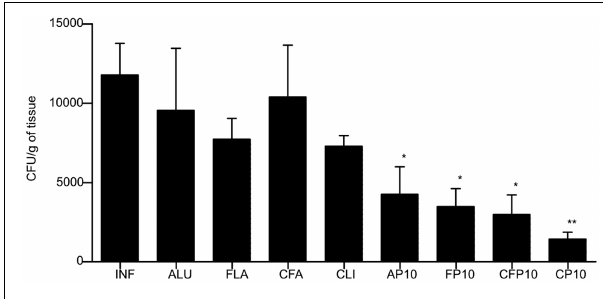
FIGURE 1 | Colony forming units (CFU) from lungs of BALB/c mice infected intratracheally with 3 × 10 5 yeast cells of Pb18 and immunized at 30, 37, and 44 days after infection with the different adjuvants with or without P10. Animals were sacrificed after 60 days of infection. Control animals were infected by not immunized (IFN).The adjuvants used were: aluminum hydroxide alone (ALU) or with P10 (AP10), FliC flagellin alone (FLA) or with P10 (FP10), complete Freund’s adjuvant alone (CFA) or with P10 (CF10), and cationic lipid alone (CLI) or with P10 (CP10). Significant difference * p < 0.05, ** p <